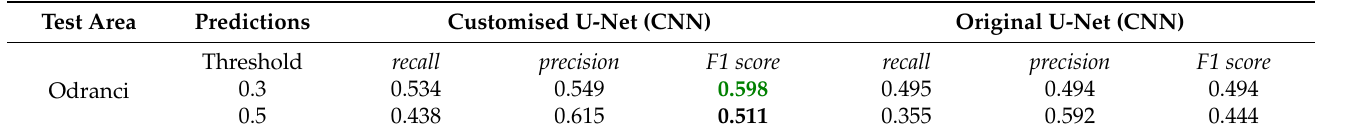
Table 4. Assessment of the detection quality of visible land boundaries and comparison of approaches—Odranci.